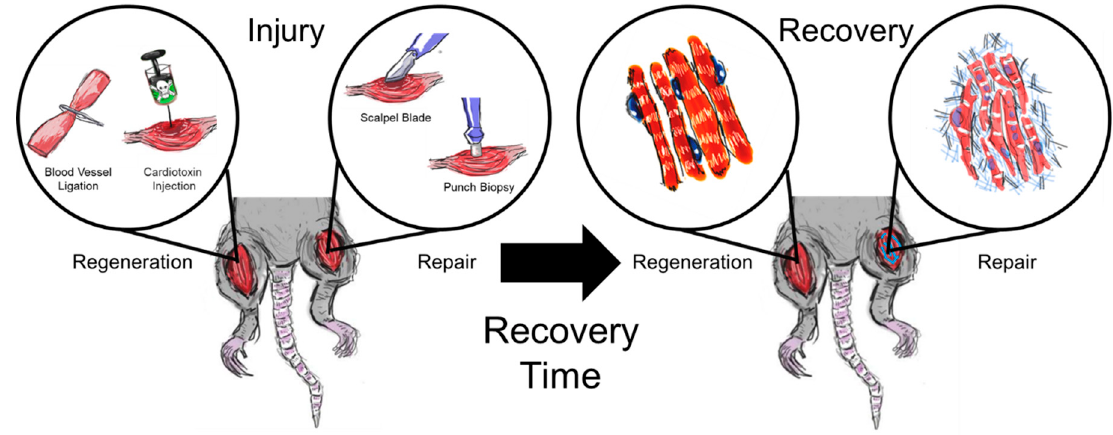
Figure 1. Injury models used to assess skeletal muscle regeneration and repair. Injury induction for regenerative models (“regeneration”) regenerate with high fidelity after recovery, while repair models (“repair”) result in some nascent myofibers interspersed with fibrotic tissue.